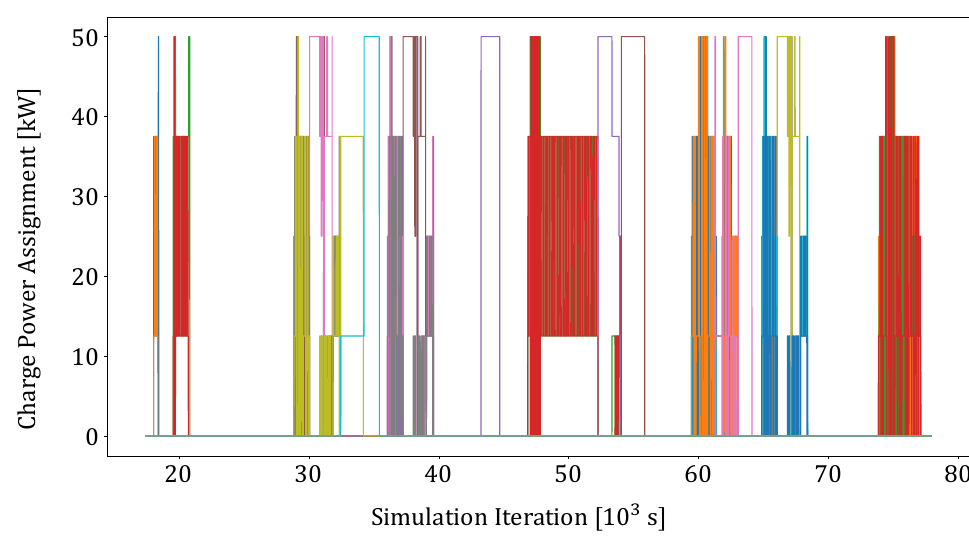
Figure 16. Overall Performance by